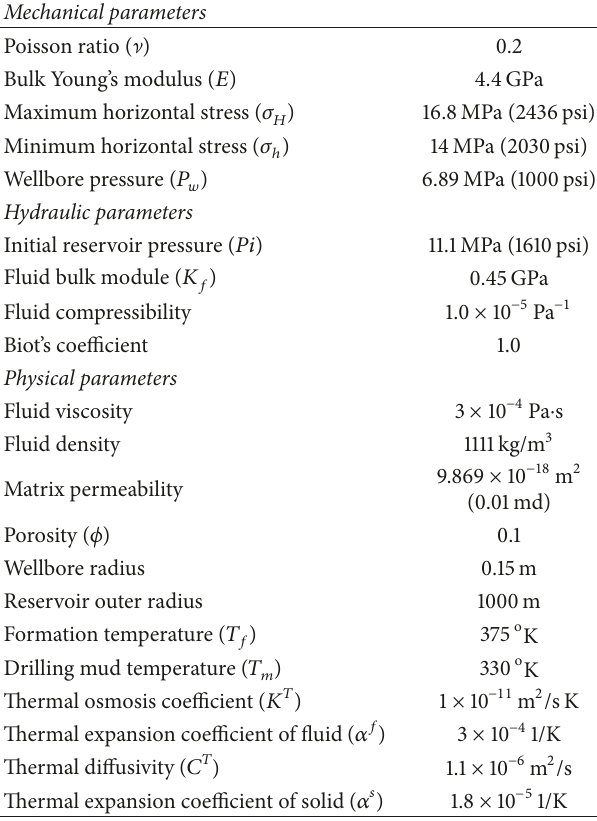
is important criterion to predict rock failure for analysis of wellbore stability [16].